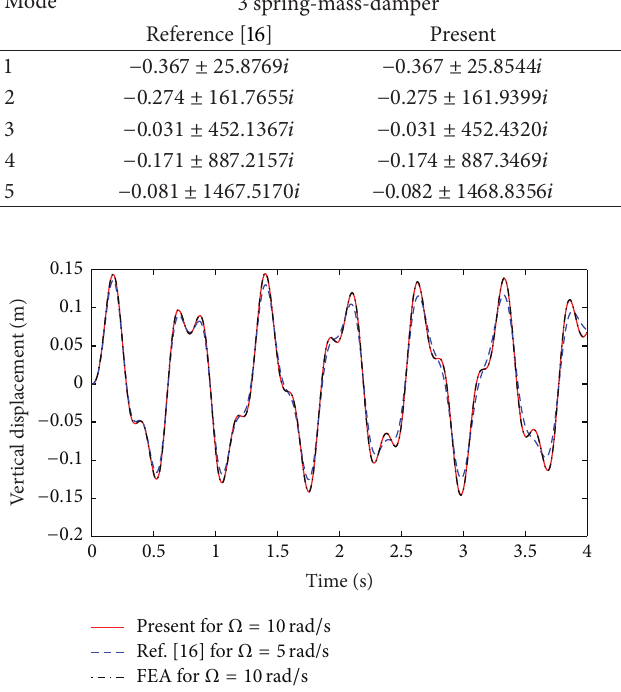
Figure 6: Frequency response amplitude error for a simply sup- ported beam carrying one in-span mass-spring-damper-mass sys- tem for 𝑘 = 10 N/m, 𝑀 𝑑 = 0.1 kg, 𝑀 𝑐 = 0.05 kg, 𝑇 = 360 N, = 0.1 Ns/m, and 𝐿 = 0.1 𝐸𝐼 = 36.458 Nm 2 , 𝑐 𝑑 𝑑